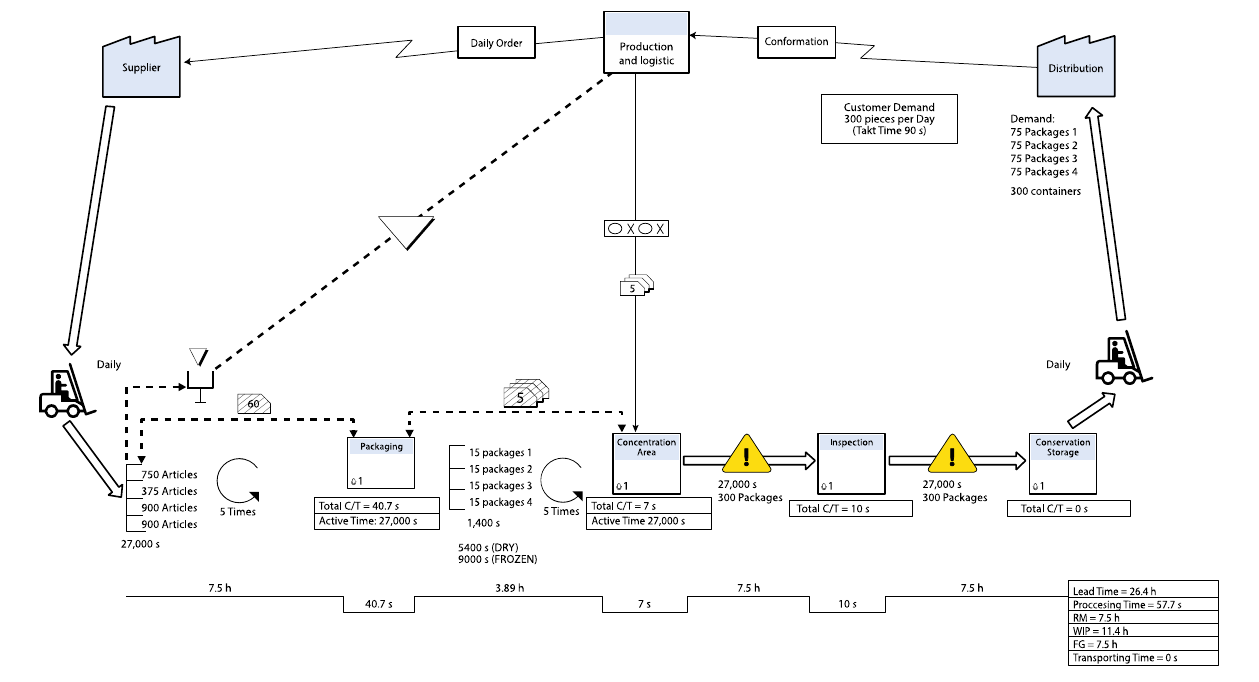
Figure 7. Optimistic VSM scenario.